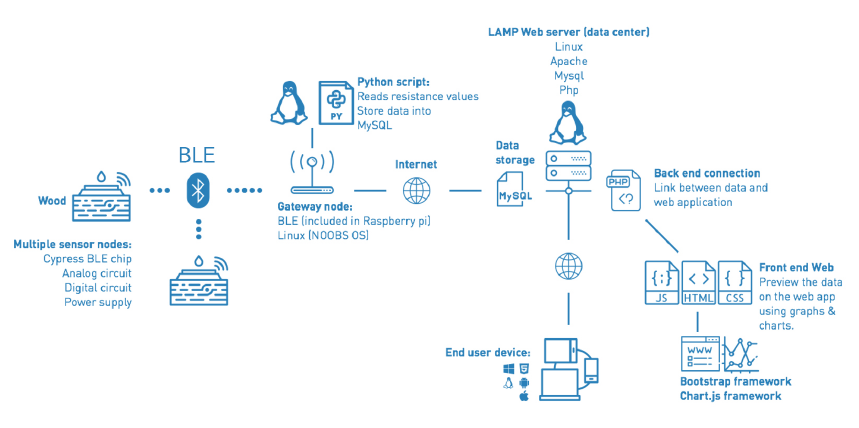
Figure 11. Project diagram, sensors send the measured values of moisture via BLE to the gateway, the remote server receives the data from the gateway via Internet and store it into its database. The user interface is connected to the database to monitor and control the sensor